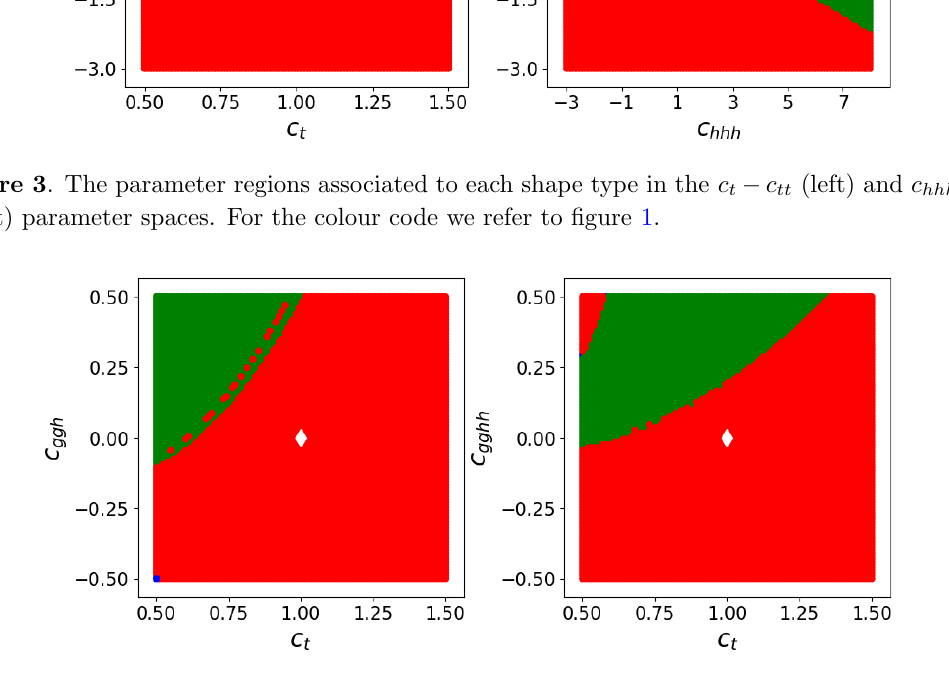
Figure 4 . The parameter regions associated to each shape type in the c t (cid:0) c ggh (left) and c t (cid:0) c gghh (right)